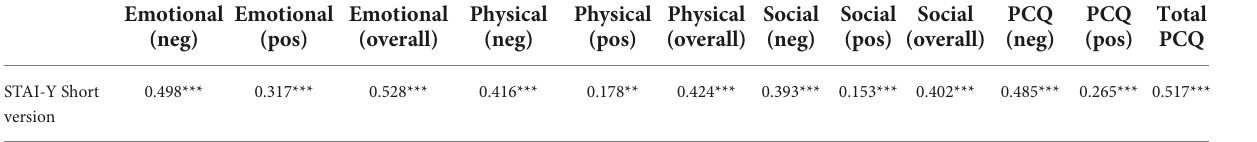
Physical Physical Physical Social Social Social PCQ PCQ Total (neg) (pos) (overall) (neg) (pos) (overall) (neg) (pos) PCQ